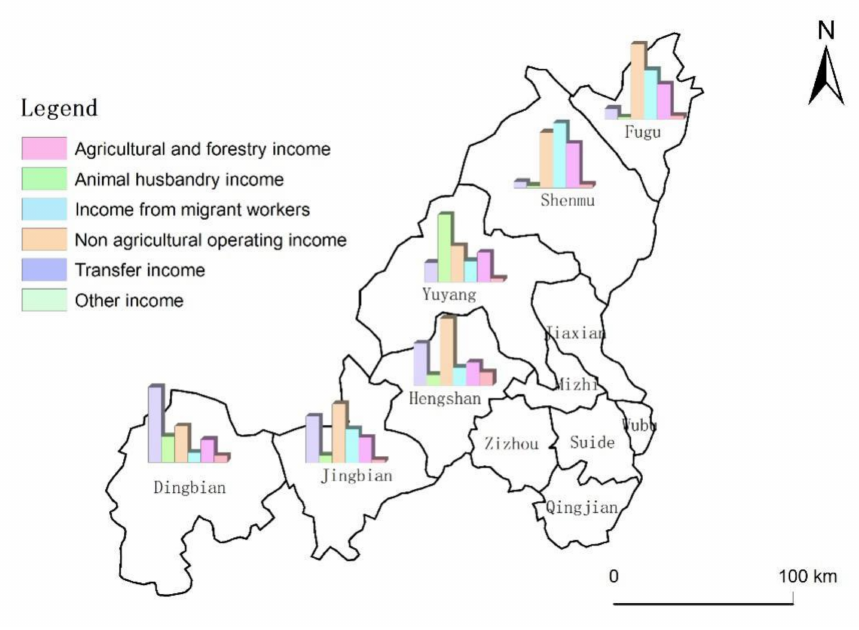
Figure 3. Differences in revenue contribution in various